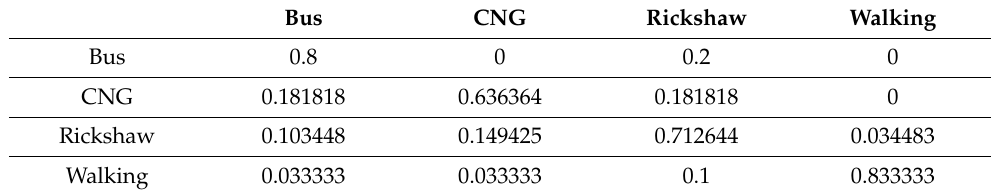
Table 5. Confusion matrix MNL.